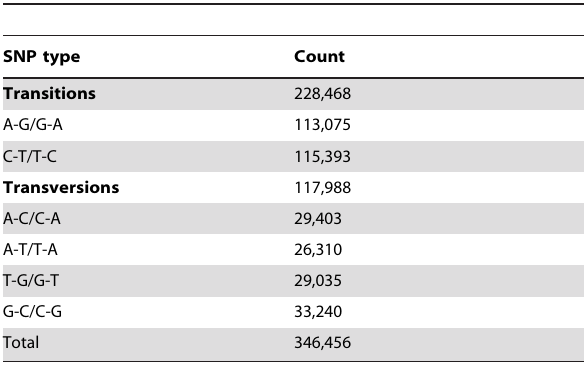
Table 7. Summary of putative SNPs found in P. maximum